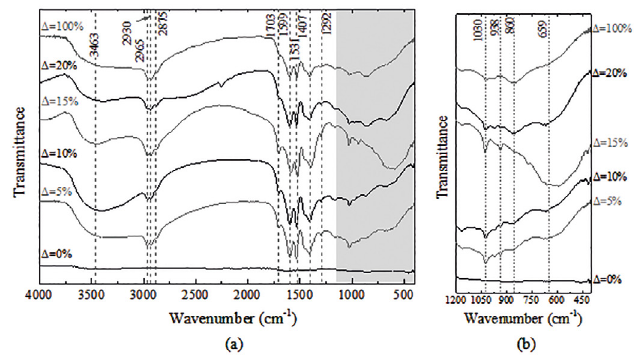
Figure 2. Infrared transmittance spectra for films deposited with different duty cycles acquired between (a) 400 and 4000 cm -1 and (b) 400 and 1200 cm -1 . The spectrum of the film deposited without the application of pulses, Δ = 0%, is also